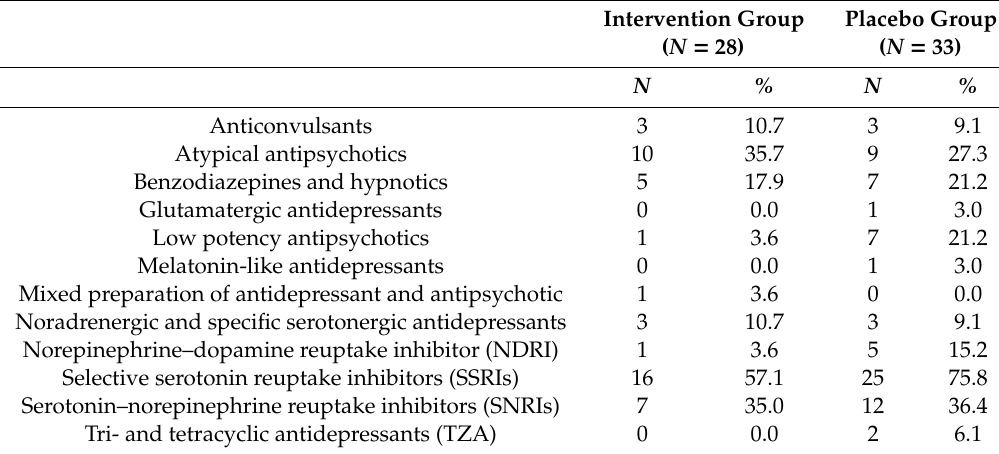
Table 2. Medication of PROVIT sample at baseline (in alphabetical order).